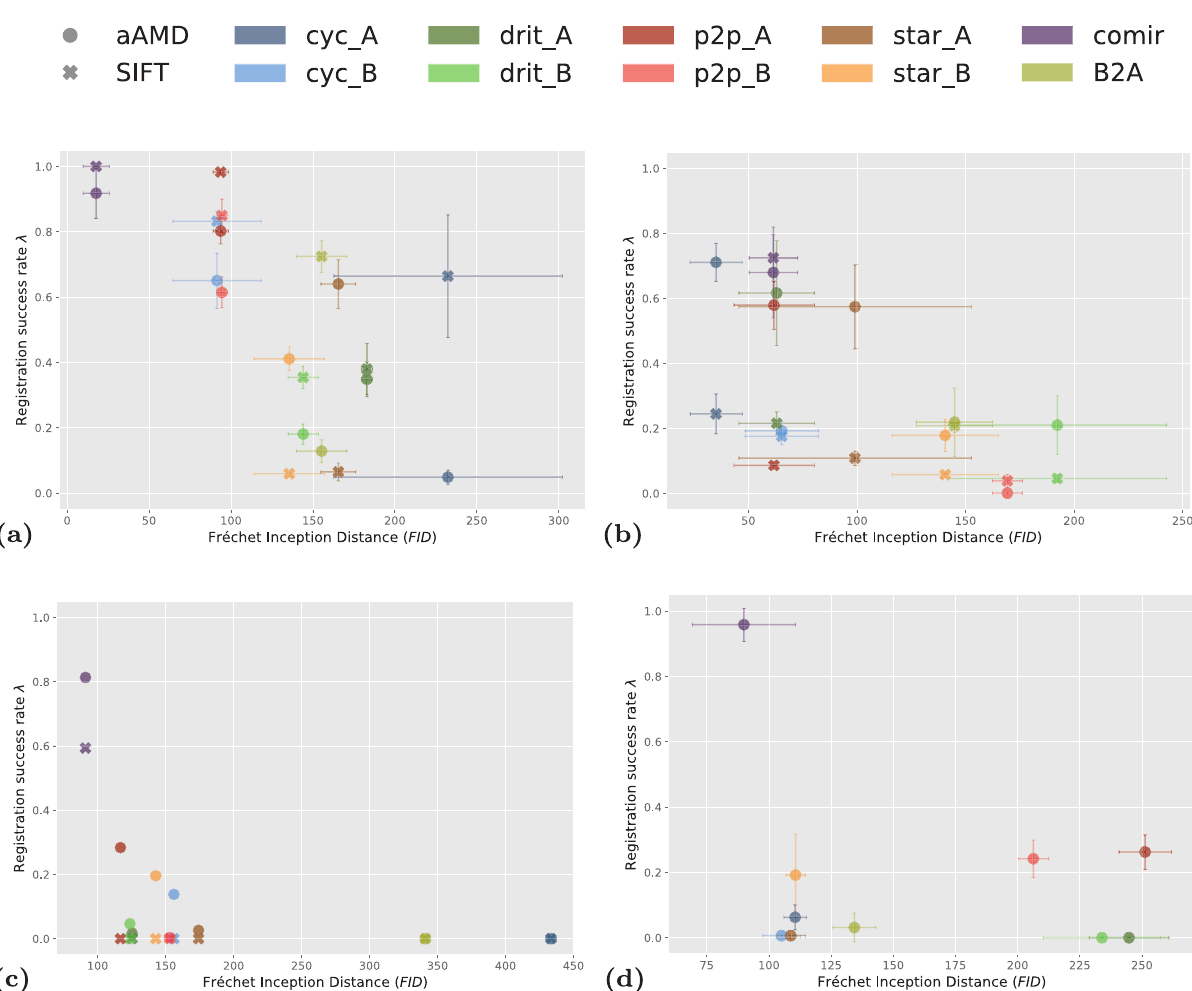
Fig 10. Relation between average FID reached by a modality translation method and the success rate λ of the subsequent registration. (A) On Zurich data, (B) on Cytological data, (C) on Histological data, (D) on Radiological data. In the legend, cyc , drit , p2p , star and comir denote the methods CycleGAN, DRIT++, pix2pix, StarGANv2 and CoMIR, respectively. Suffix _A (resp. _B) denotes that generated Modality A (resp. B) is used in (monomodal) registration. The marker style indicates whether α -AMD ( aAMD ) or SIFT ( SIFT ) is used for the registration. The error-bars correspond to standard deviation computed over 3 folds for Zurich, Cytological and Radiological